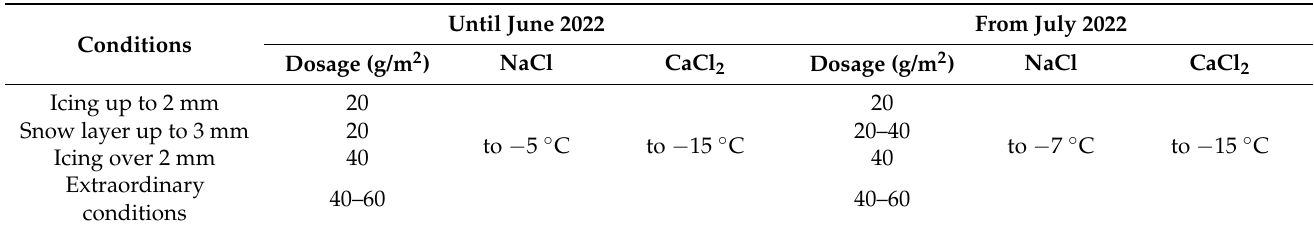
Table 1. Recommended dosage of chemical de-icing materials in Slovakia.